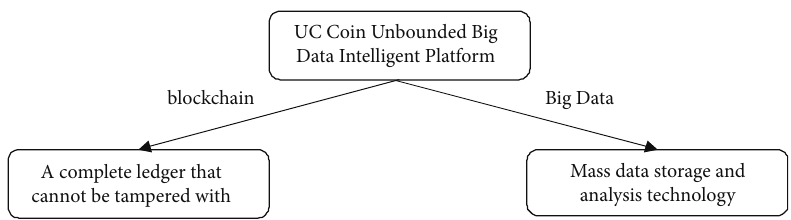
Figure 7: The complete model framework